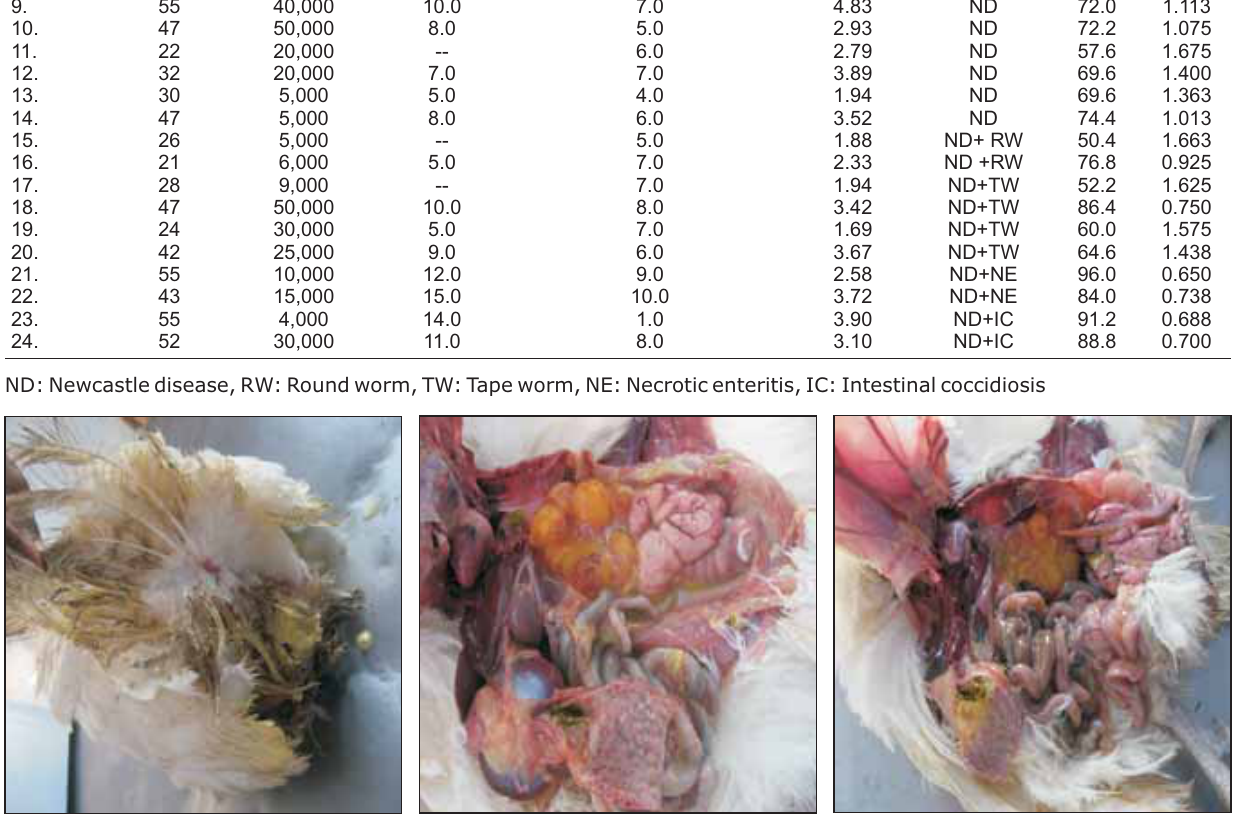
Figure-1: ND : Bird showing whitish to greenish diarrhoea